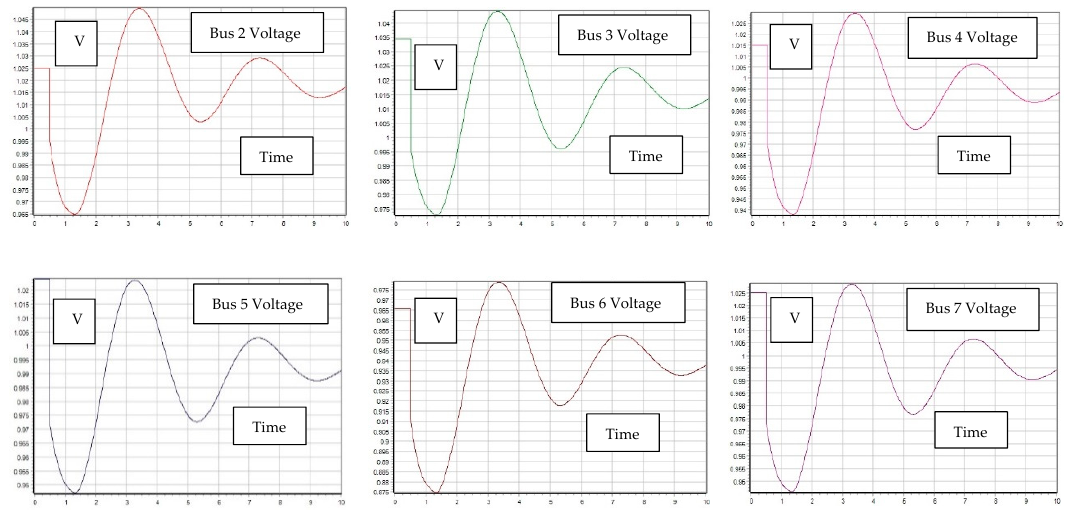
Batteries 2021 , 7 , x FOR PEER REVIEW 10 of 19